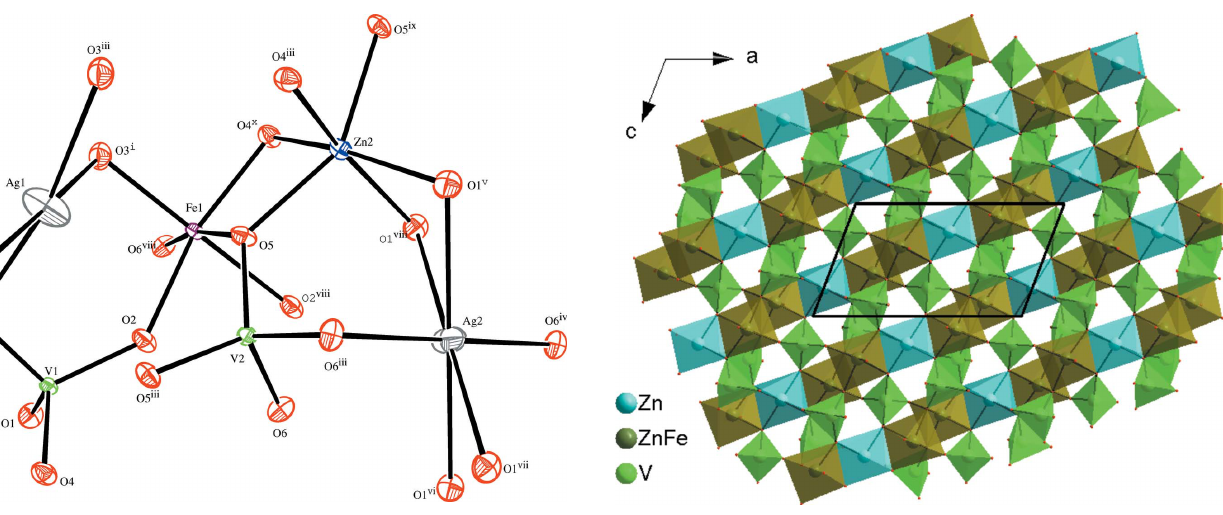
Figure 1 Figure 3 The principal building units in the structure of the title compound. A layer perpendicular to (010), resulting from the connection of chains Displacement ellipsoids are drawn at the 50% probability level. via the vertices of VO 4 tetrahedra and [ZnO 6 ] octahedra. [Symmetry codes: (i) x , (cid:3) y + 1, z (cid:3) 1 ; (ii) (cid:3) x + 1, (cid:3) y + 1, (cid:3) z + 2; (iii) 2 (cid:3) x + 1, y , (cid:3) z + 3 ; (iv) x , (cid:3) y , z (cid:3) 1 ; (v) x + 1 , (cid:3) y + 1 , z (cid:3) 1 ; (vi) (cid:3) x + 1 , y (cid:3) 1 , 2 2 2 2 2 2 2 (cid:3) z + 3